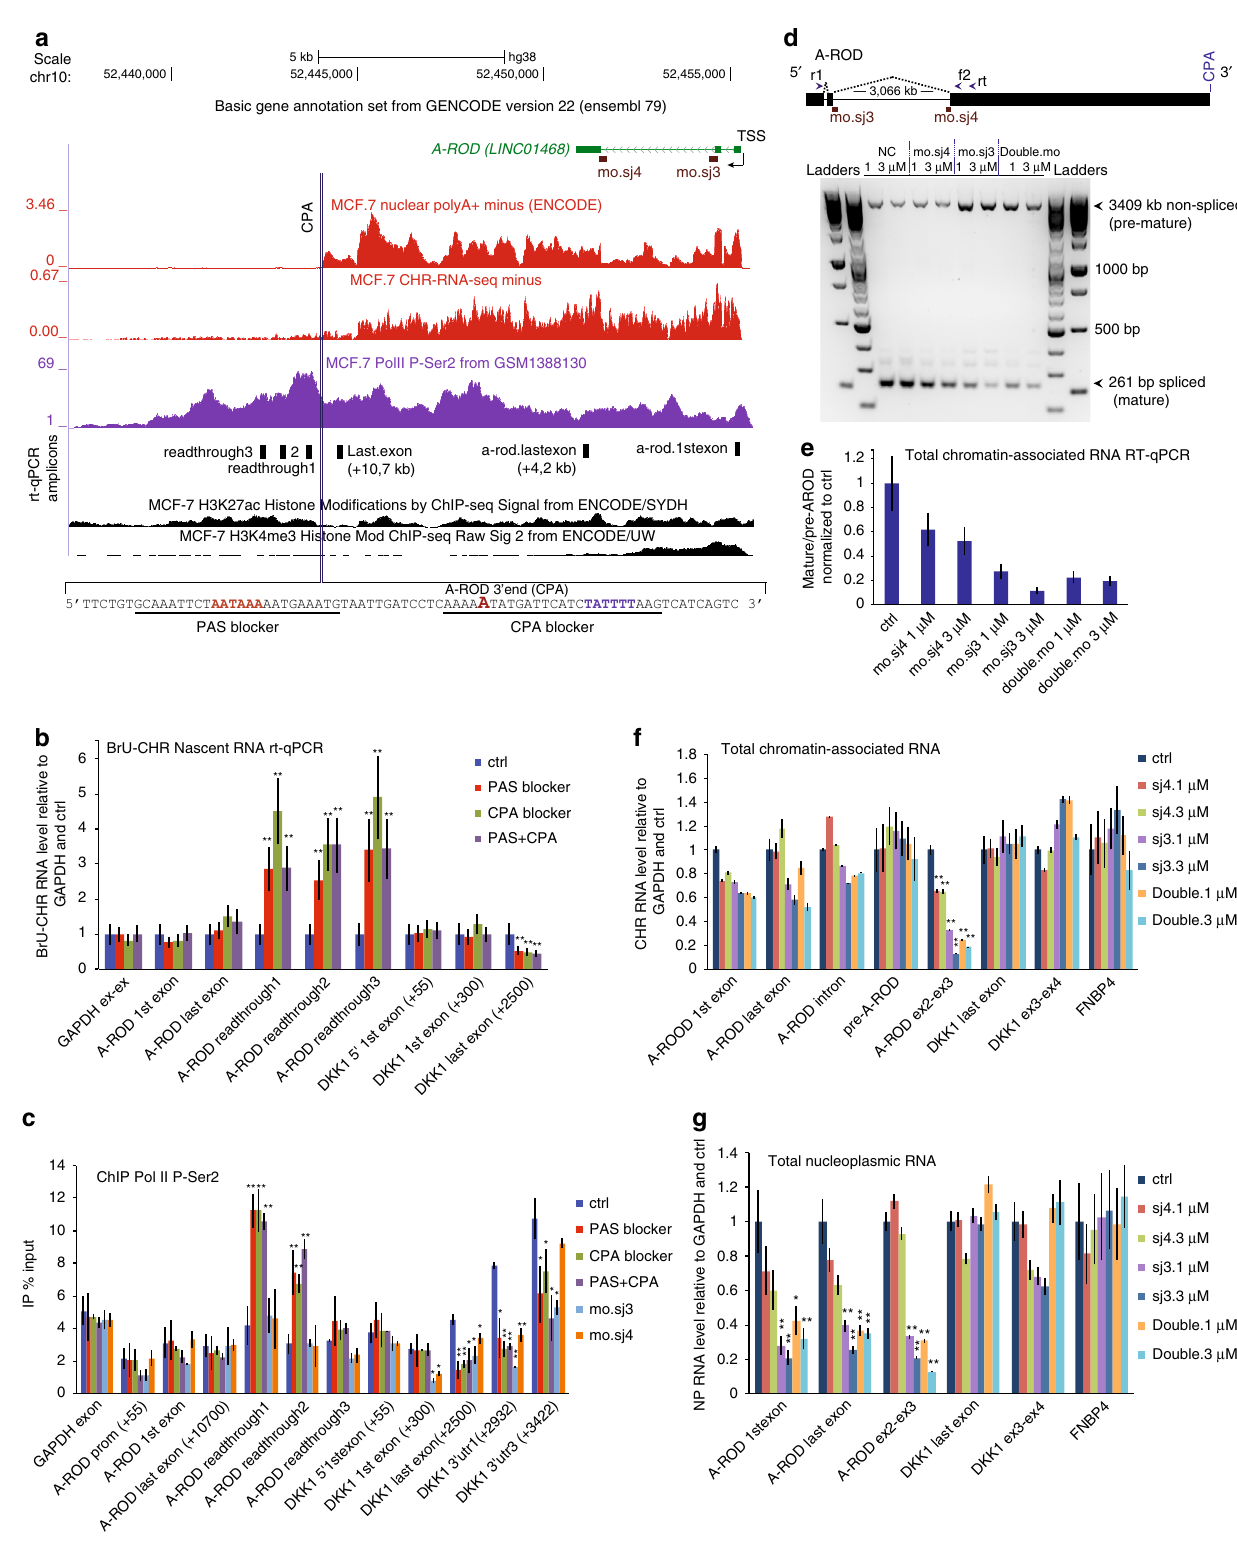
MCF.7 nuclear polyA+ minus (ENCODE)